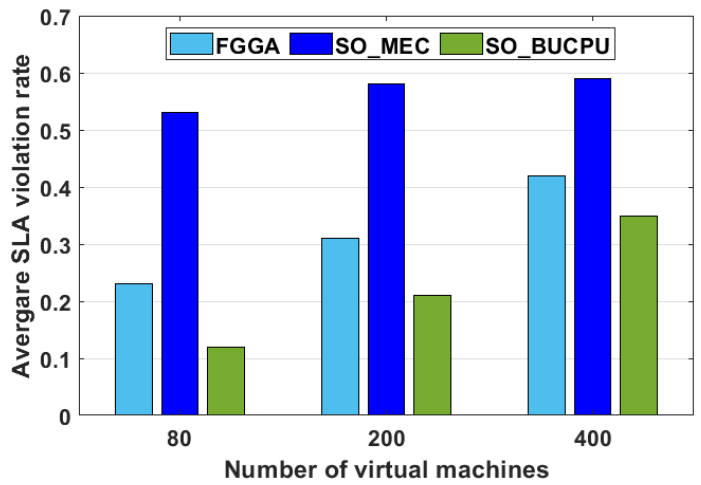
Figure 10. Comparison of average SLA violation rates.